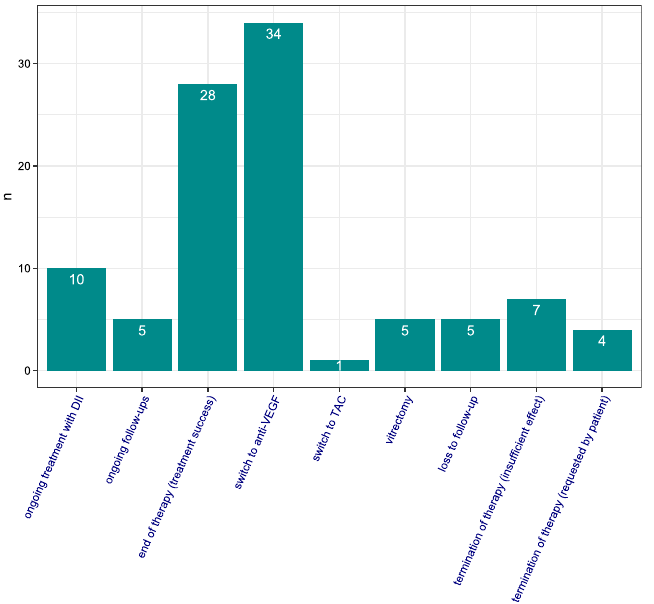
Figure 2. Outcome at end of observation. At the end of our observation window, ten eyes, (10%) were receiving ongoing DII treatment and five eyes (5%) had ongoing follow-up control visits. 28 eyes (28%) had been released from follow-up as treatment success. 34 eyes (34%) were switched to anti-VEGF therapy and five eyes (5%) required a vitrectomy. Five eyes (5%) were lost to follow-up and in 11 eyes (11%) further interventions were either considered not likely to yield benefit (seven eyes, 7%) or were stopped according to patient’s decision (four eyes,